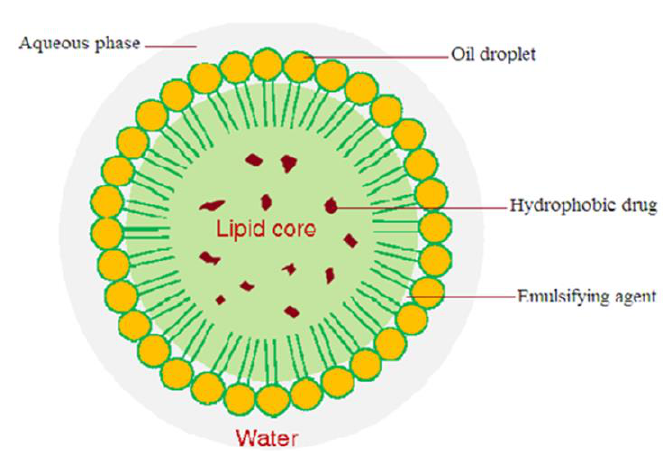
Fig. 10. Generalized structure of